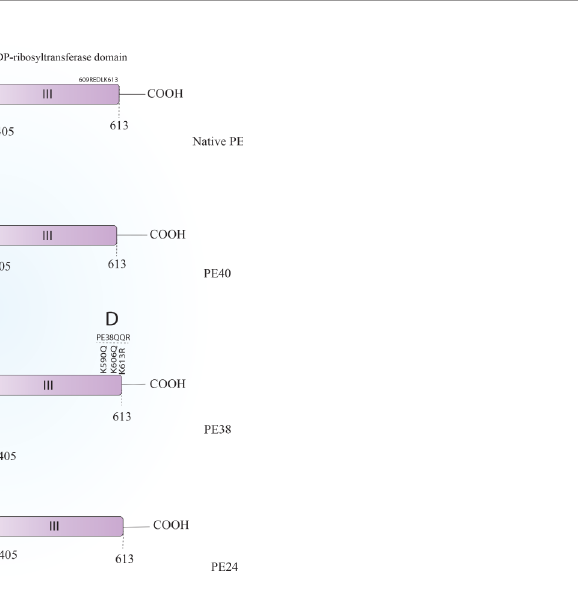
FIGURE 1 | Schematic representation of Pseudomonas exotoxin A (A) and its most applicable derivatives. In order to reduce PE – ITs, non-speci fi c toxicities, immunogenicity, and size, various PE derivatives have been evaluated, most of which are PE40 (B) , PE38 (C) , PE38QQR (D) , and PE24 (E) . PE, Pseudomonas exotoxin A; IT,